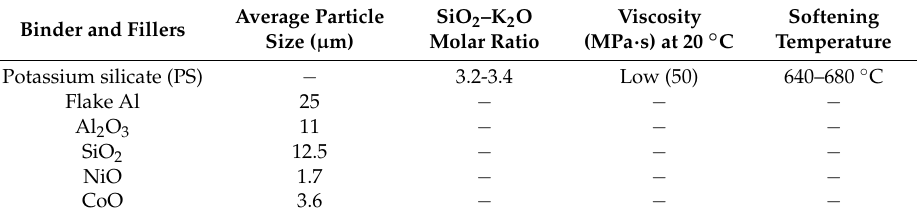
Table 2. Some properties of chosen binders and fillers (manufacturer’s data).